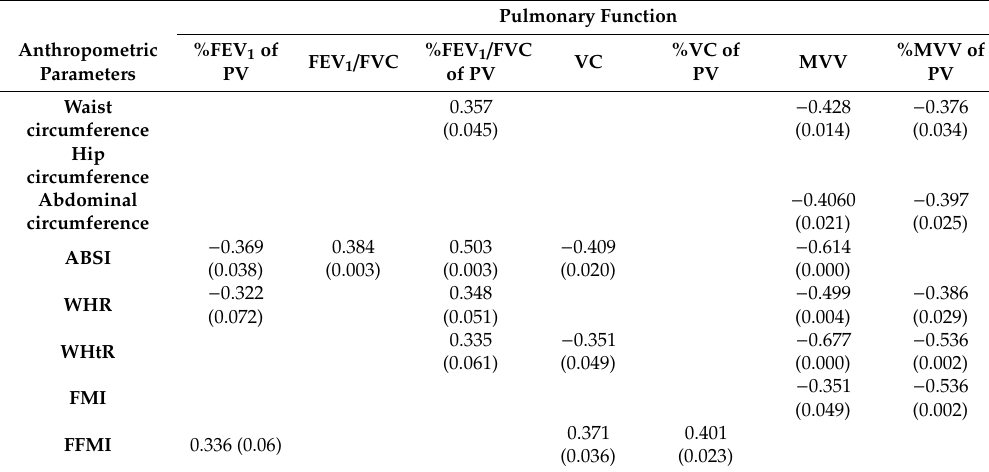
Table 4. Bivariate analysis between Pulmonary Function Tests (PFT) parameters and anthropometric parameters in firefighters ( n = 32), Pearson correlation coe ffi cient ( p